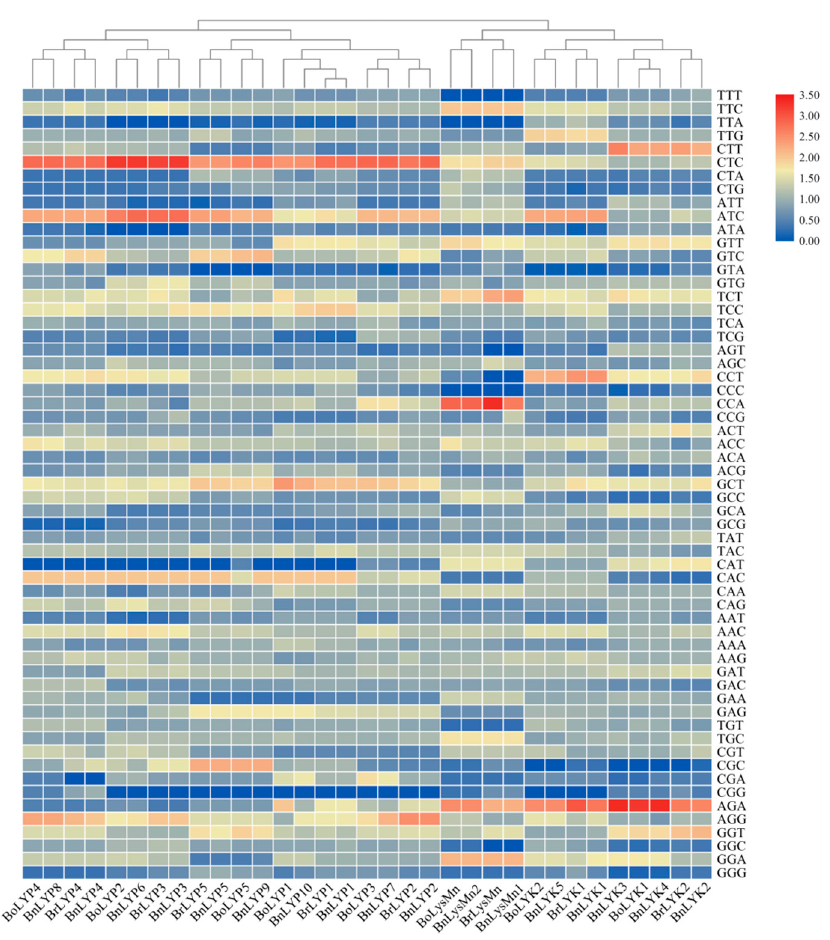
Figure 9. Relative synonymous codon usage analysis (RSCU) values of Brassica LysM-RLKs are represented as a heat map. The color boxes represent RSCU values, with the lowest (blue) and maximum (red) codon usage. TBtools was used to construct the heatmap.